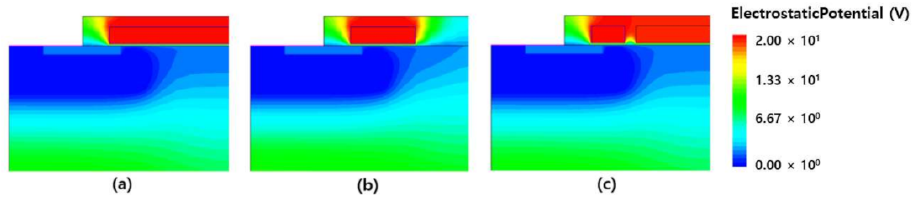
Figure 9. Electron current density of ( a ) C-DMOSFET (conventional planar DMOSFET); ( b ) SG- DMOSFET (split-gate DMOSFET); and ( c ) FPS-DMOSFET (floating p+ polysilicon DMOSFET) in the on state ( V GS = 20 V, V DS = 20 V).